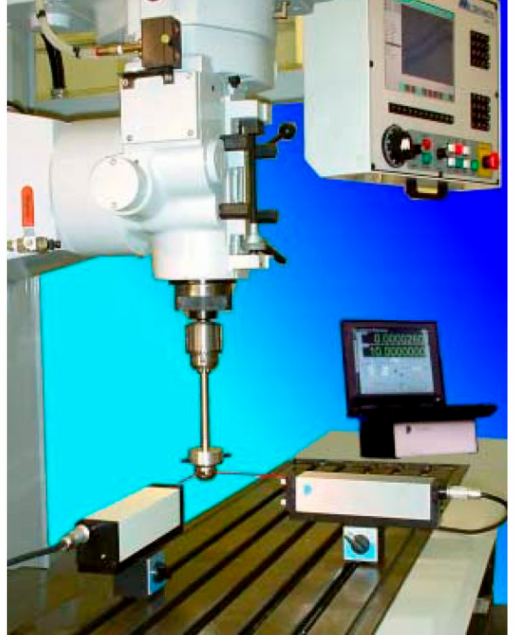
Figure 17. Optodyne set for the measurement of error movements [24]. One laser head measures in the X direction, and the other measures in the Y direction. As shown in Figure 18, first, a ball standard is set at the axis of rotation of the spindle with 4 fine-pitch screws, and then, the spindle is rotated 180 degrees.